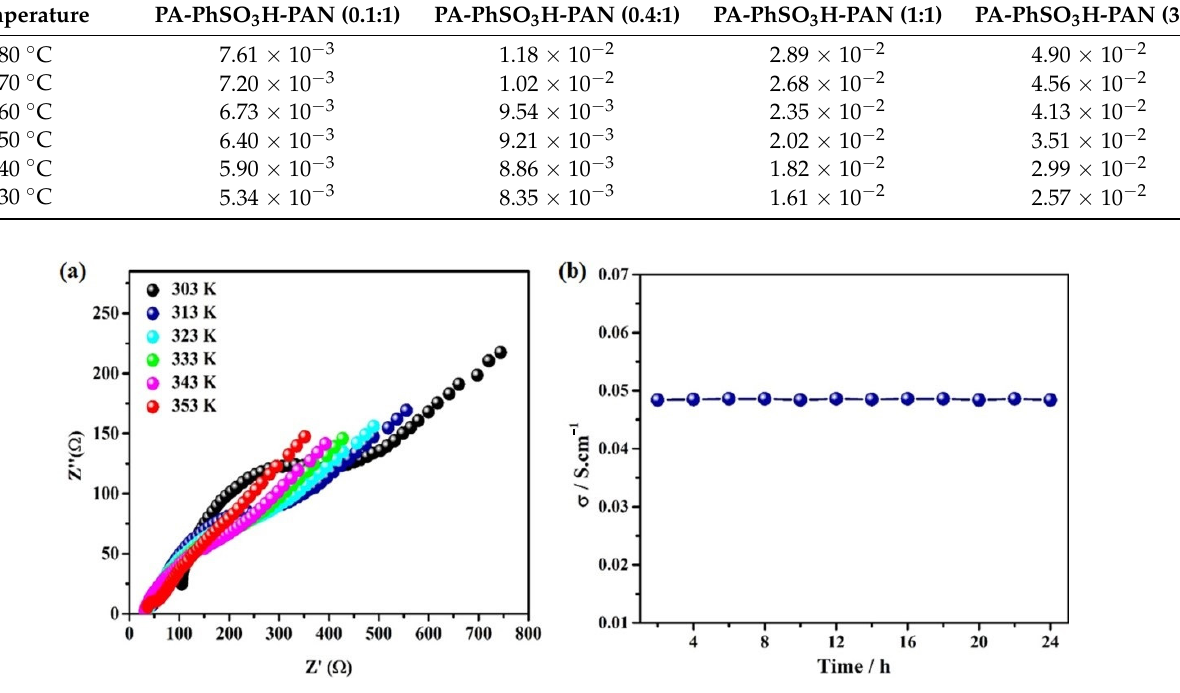
Figure 6. ( a ) Nyquist plot at 98%RH and different temperatures and ( b ) Long-life reusability test at 80 ◦ C and 98% RH of PA-PhSO 3 H-PAN (3:1)